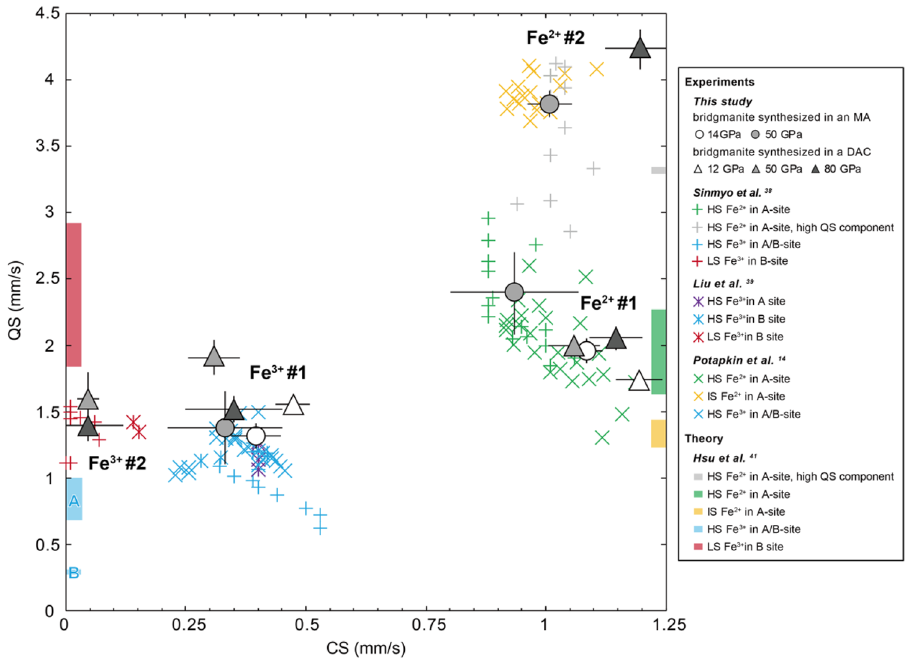
Figure 3. Mössbauer parameters of bridgmanite. Triangles, bridgmanite synthesized in a DAC (this study); circles, bridgmanite synthesized in an MA (this study). The reported Mössbauer parameters of bridgmanite are also plotted as a reference: plus symbols, Sinmyo et al. 38 ; stars, Liu et al. 39 ; crosses, Potapkin et al. 14 , respectively. The differences in colours represent the differences in assigned sites in previous studies: green, grey, yellow, light blue, and red symbols indicate the Mössbauer parameters assigned to HS Fe 2+ in the A site, HS Fe 2+ in the A site with a high QS component, intermediate-spin (IS) Fe 2+ in the A site, HS Fe 3+ in the A/B site, and LS Fe 3+ in the B site, respectively. Density functional theory results for Fe 3+ are shown on the left, and those for Fe 2+ are shown on the right 41